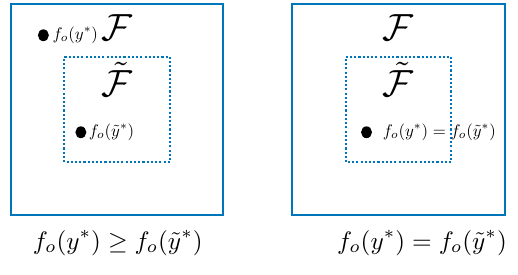
Figure 6 . The two possible cases: In each f